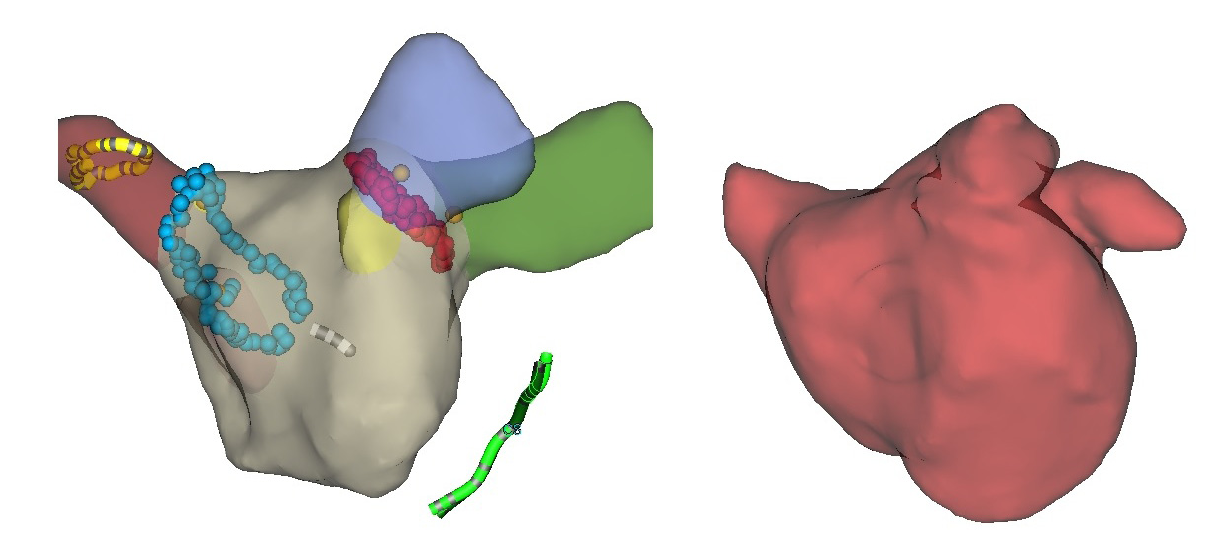
Fig. 3. On the right, there is a 3D image of the left atrium obtained from three-dimensional rotational angiography. On the left, there is shown an electroanatomical map of the left atrium based on the image obtained from CT (the red and blue points mark location of RF